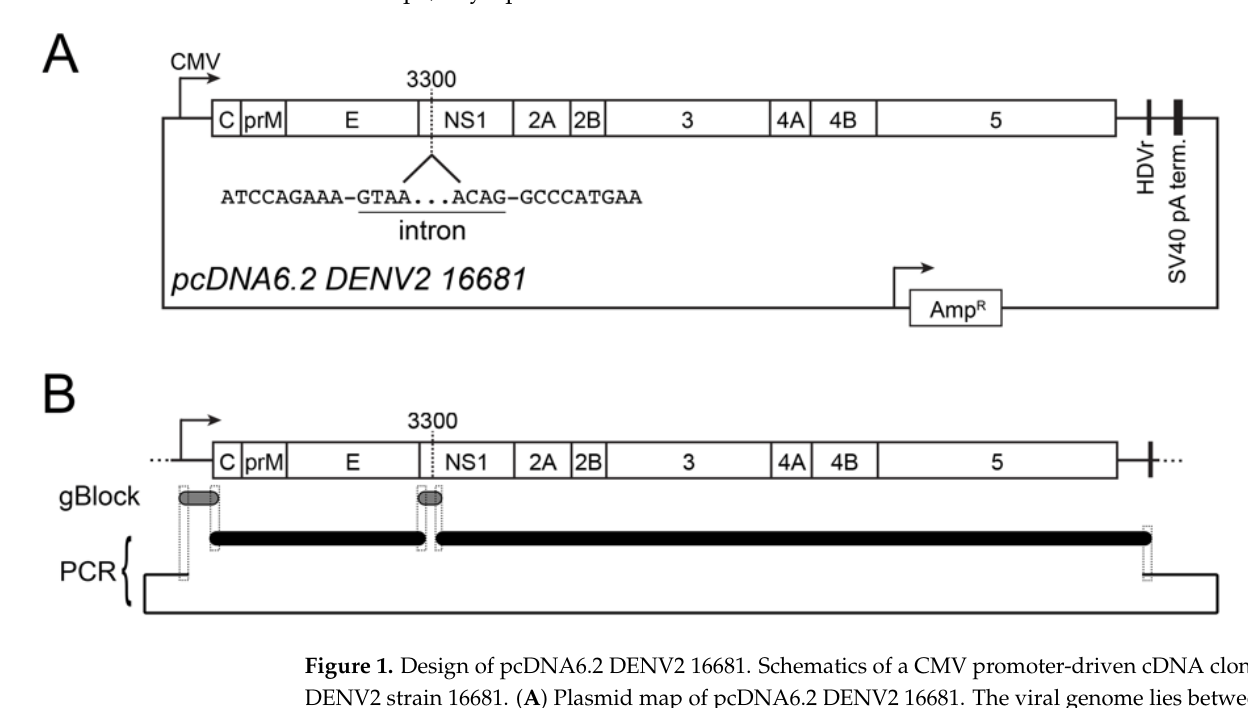
Figure 1. Design of pcDNA6.2 DENV2 16681. Schematics of a CMV promoter-driven cDNA clone of DENV2 strain 16681. ( A ) Plasmid map of pcDNA6.2 DENV2 16681. The viral genome lies between a CMV promoter and HDVr, followed by an SV40 polyA termination sequence. The location of the artificial intron is indicated at nucleotide 3300. The underlined sequence corresponds to the 5′ and 3′ ends of the intron. ( B ) Construction of pcDNA6.2 DENV2 16681. Overlapping regions between gBlocks (grey) and PCR products (black) are shown by dashed line boxes. Table 1. Primer and gBlock sequences.